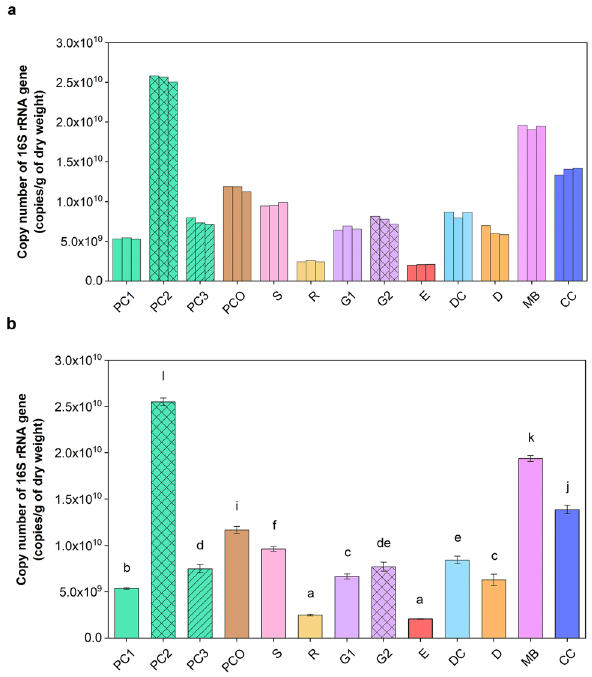
Figure 1. Quantification of 16S rRNA gene copies showing ( a ) the individual results from independent triplicate repeats and ( b ) mean ± S.D., in different livestock manure samples (per g DW) using qPCR. In ( b ), different letters above the bar indicated statistically significant differences among samples (one-way ANOVA with Waller Duncan test, p <